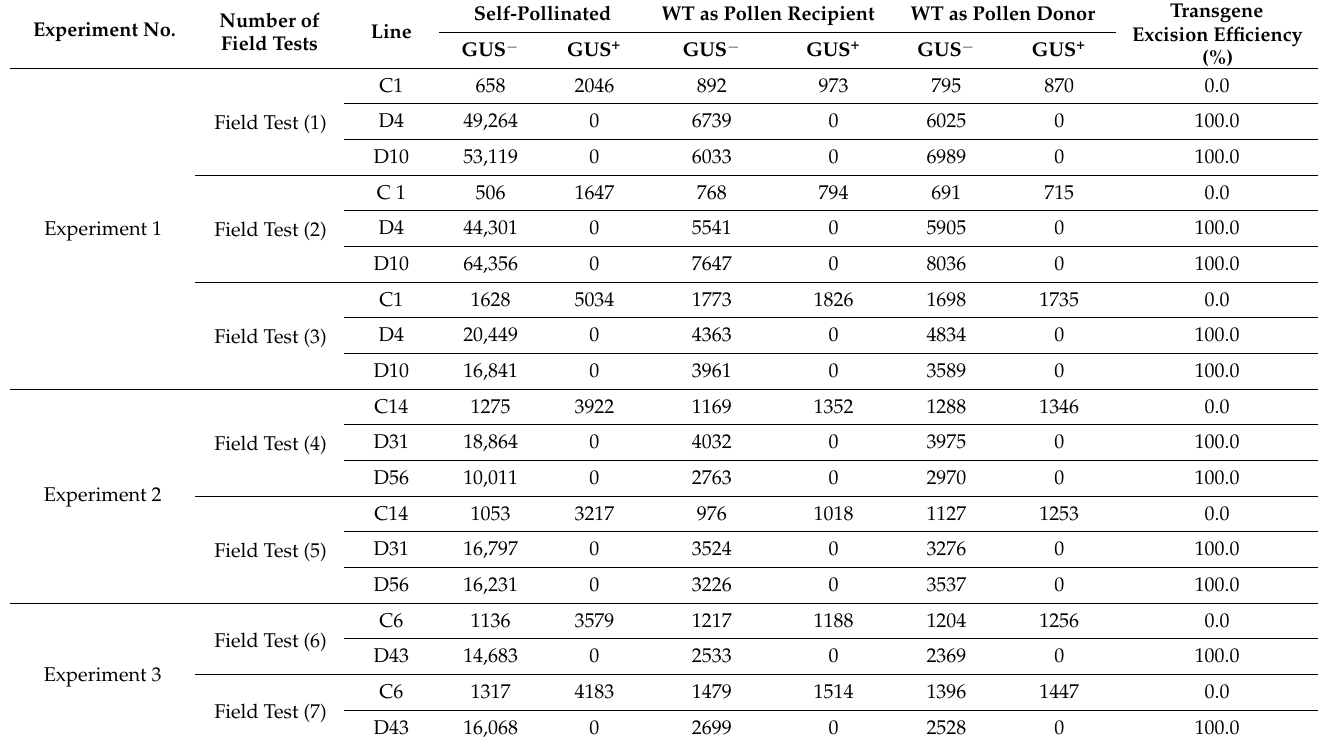
Table 3. Transgene excision efficiency in the pollen and seeds of transgenic plants grown in the field; transgene excision efficiency was determined based on GUS staining of the T1 seedlings. Lines C1, C14, and C6 (control lines); lines D4, D10, D31, D56, and D43 (lines with “Gene Deletor” cassette).